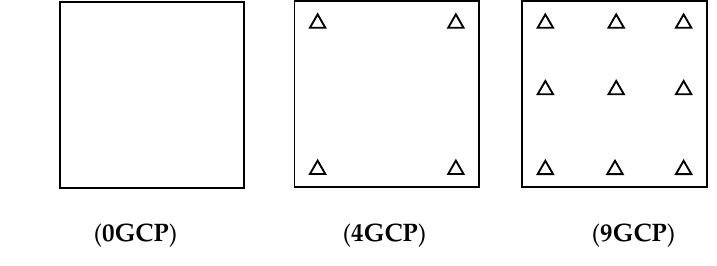
Figure 3. GCP scheme.